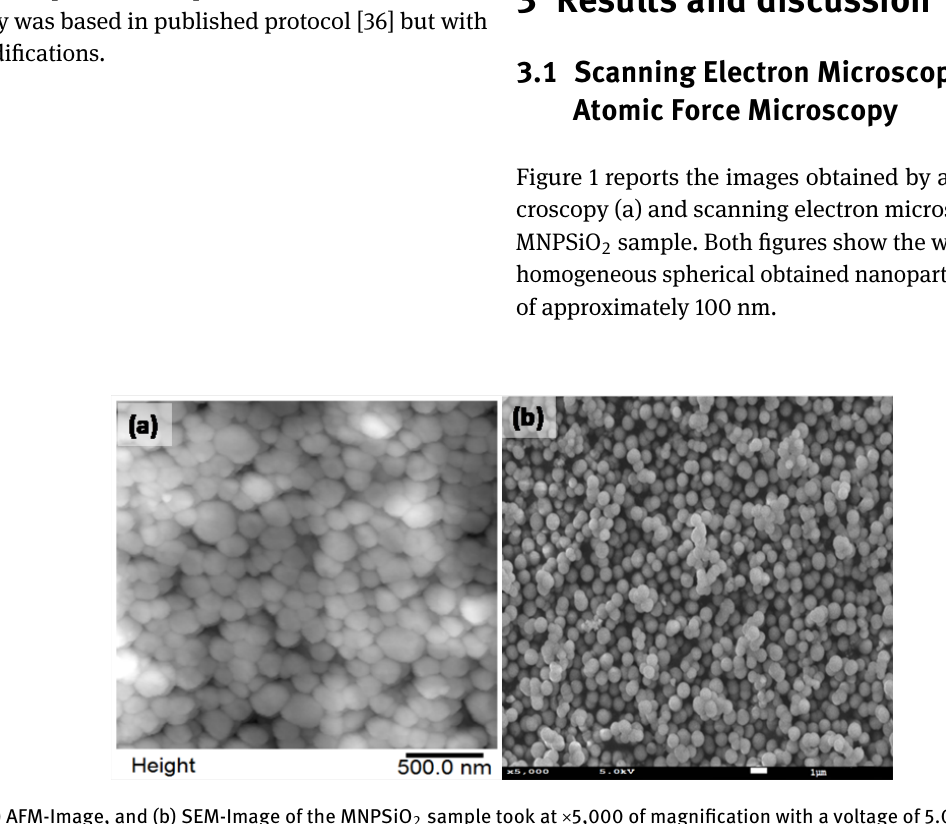
Figure 1: (a) AFM-Image, and (b) SEM-Image of the MNPSiO 2 sample took at × 5,000 of magnification with a voltage of 5.0 kV. The bar is equivalent to 1 µ m.